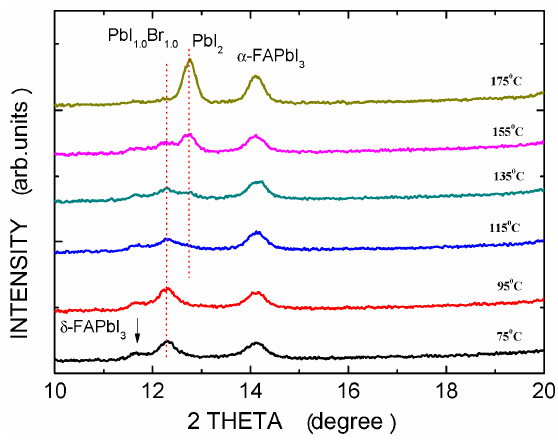
Figure 3. XRD patterns of (FAPbI 3 ) 0.8 (MAPbBr 3 ) 0.2 perovskite films following annealing at various temperatures.